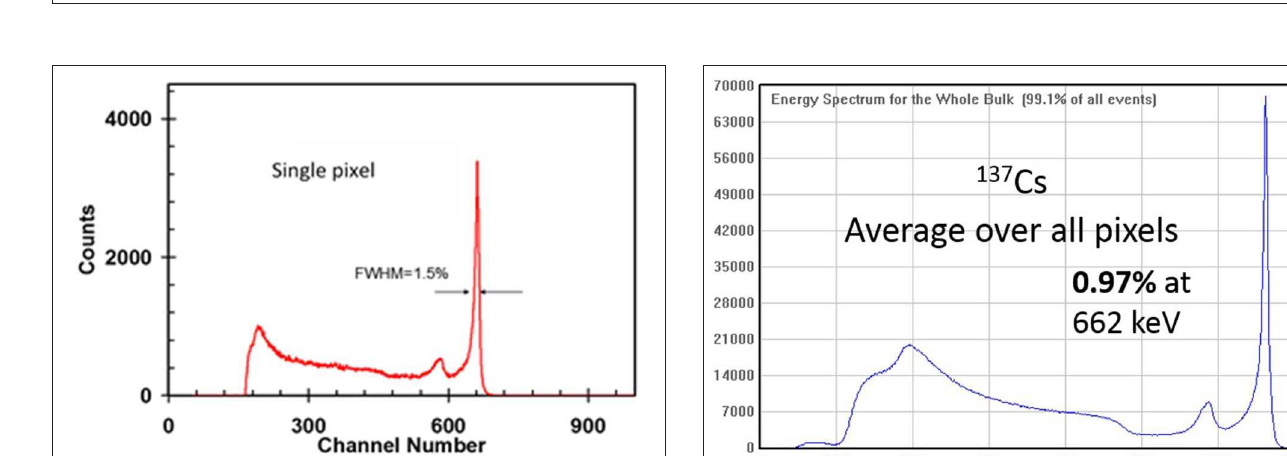
array (1.0 mm pitch) with guard ring and depth corrected 137 Cs spectrum from single pixel events from the full array. The depth corrected energy resolution for single pixel events from the full array (excepting pixels from which peaks could not